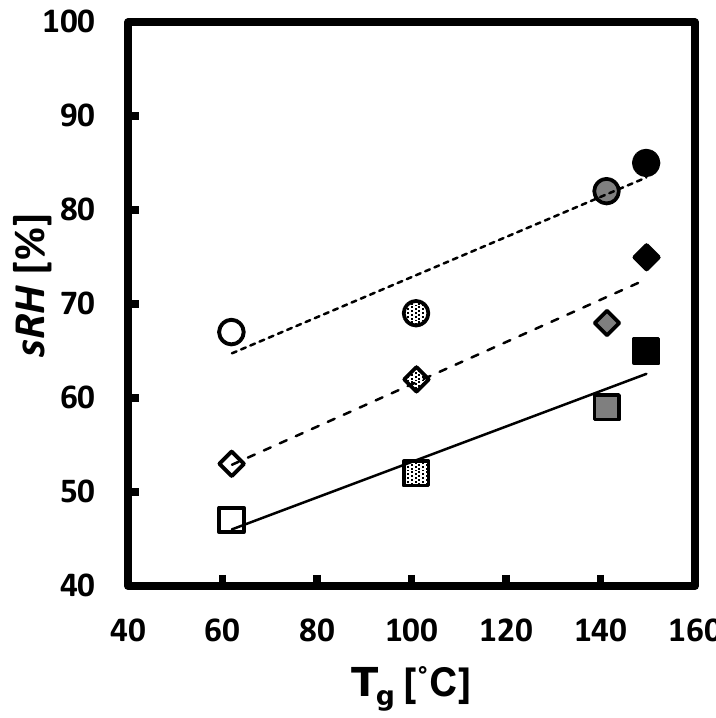
T [˚C] g Figure 6. Relationship between the release start humidity, relative humidities (RHs) and glass Figure 6. Relationship between the release start humidity, relative humidities (RHs) and glass Figure 6. Relationship between the release start humidity, relative humidities (RHs) and glass transition Figure 6. Relationship between the release start humidity, relative humidities (RHs) and glass Figure 6. Relationship between the release start humidity, relative humidities (RHs) and glass transition temperature of wall material  : 40 °C,  : 50 °C, and  : 60 °C. Open key : Suc, dot pattern: transition temperature of wall material  : 40 °C,  : 50 °C, and  : 60 °C. Open key : Suc, dot pattern: transition temperature of wall material  : 40 °C,  : 50 °C, and  : 60 °C. Open key : Suc, dot pattern: temperature of wall material : 60 °C. Open key: Suc, dot pattern: Lac, gray transition temperature of wall material  : 40 °C,  : 50 °C, and  : 60 °C. Open key : Suc, dot pattern: Lac, gray pattern: MD (DE = 25), and closed key : MD (DE = 19). pattern: MD (DE = 25), and closed key: MD (DE = Lac, gray pattern: MD (DE = 25), and closed key : MD (DE = 19). Lac, gray pattern: MD (DE = 25), and closed key : MD (DE = 19). Lac, gray pattern: MD (DE = 25), and closed key : MD (DE = 19).